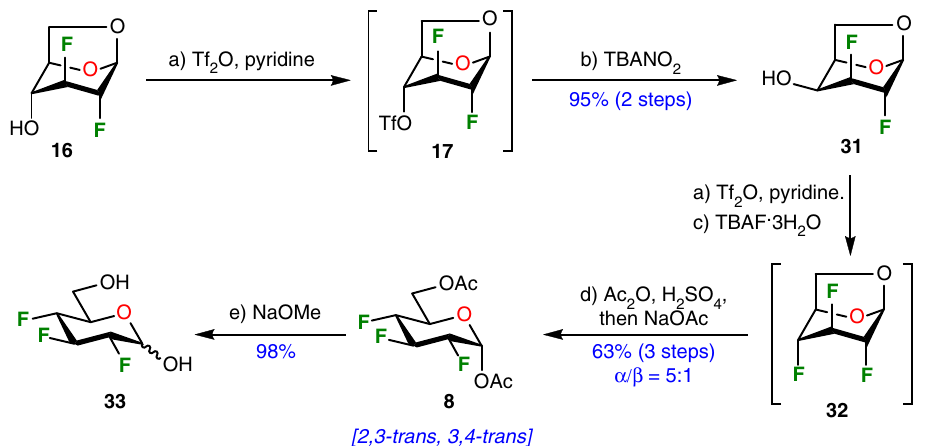
Fig. 5 Stereoselective synthesis of 2,3,4-trideoxy-2,3,4-tri fl uoroglucopyranose 33 . Reagents and conditions: (a) Tf 2 O (2.0 equiv), pyridine (3.0 equiv), CH 2 Cl 2 , 0 °C, 0.5 h; (b) TBANO 2 (3.0 equiv), CH 3 CN, microwave irradiation, 100 °C, 3 h, 95% over 2 steps; (c) TBAF·3H 2 O (1.5 equiv), CH 2 Cl 2 , rt, 18 h; (d) Ac 2 O (30 equiv), H 2 SO 4 (10 equiv), 0 °C to rt, 18 h, then NaOAc (20 equiv), rt, 0.3 h, 63% over 3 steps, α / β = 5:1; (e) 1 M NaOMe, MeOH, rt, 1 h, 98%.